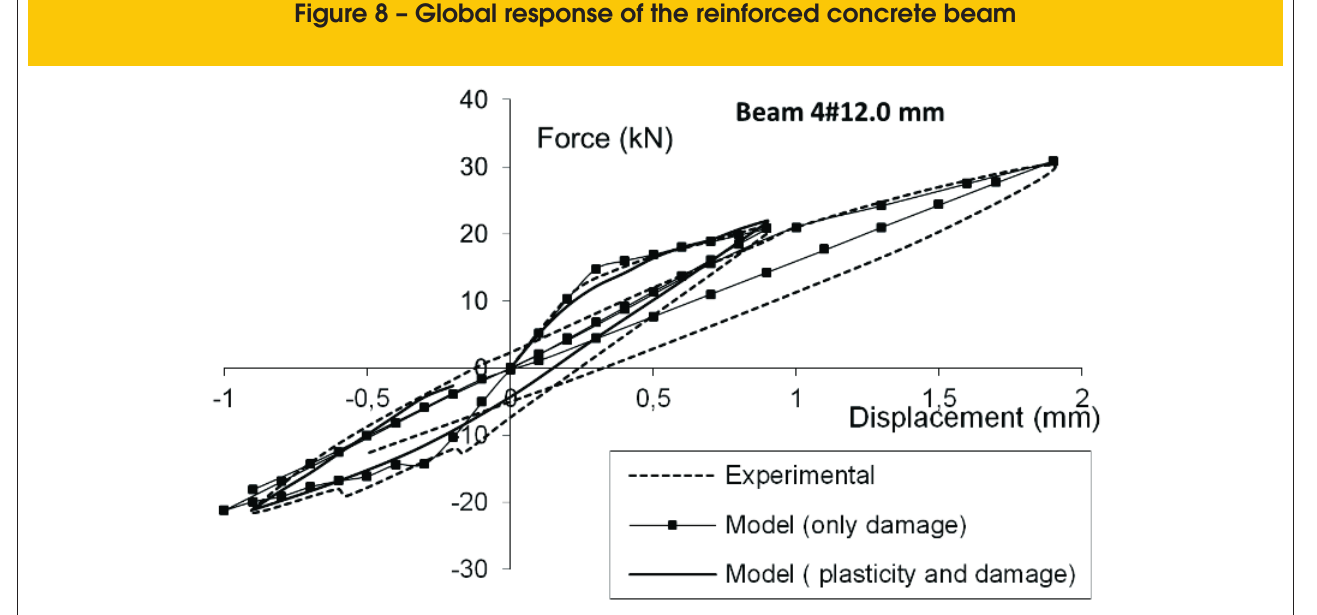
Figure 8 – Global response of the reinforced concrete